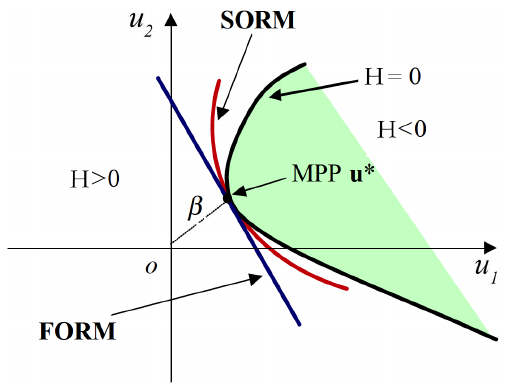
Figure 4. Comparison of first and second order reliability methods (FORM and SORM). MPP: most probable